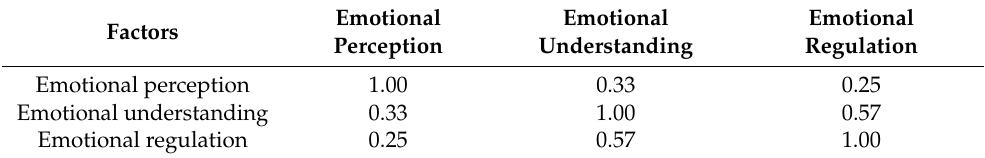
Table 4. Correlation matrix between the factors that make up emotional intelligence. Factors